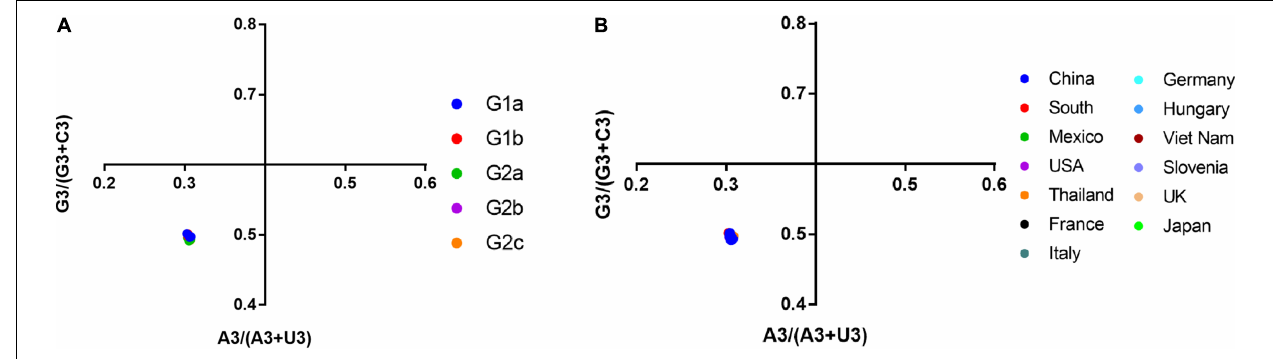
FIGURE 7 | Parity Rule 2 (PR2)-bias plot [A3/(A3 + U3) against G3/(G3 + C3)]. The PR2 bias plot was calculated for the PEDV complete coding sequence. G3/(G3 + C3) and A3/(A3 + U3) are horizontal and vertical axes, respectively. (A) Plot classified by phylogroups. (B) Plot classified by country.